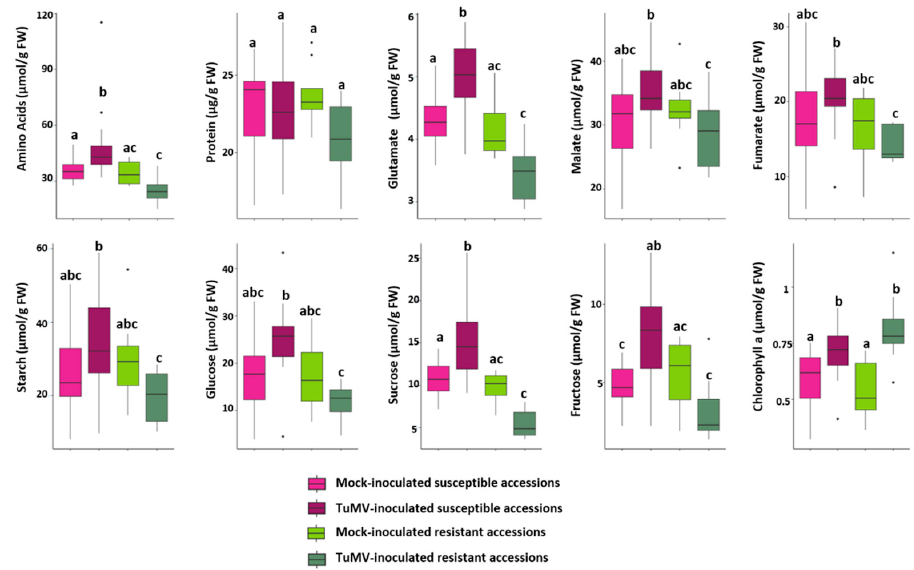
Figure 2. Comparisons of central metabolic content in mock-inoculated and TuMV-inoculated resistant and susceptible A. thaliana accessions in the 2015 field experiment. Boxplot sharing the same letter are not significantly different, at the chosen level (default 5%).